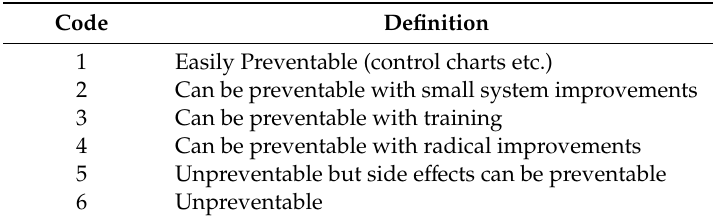
Table 2. Preventability Scale (Adapted from [65]).